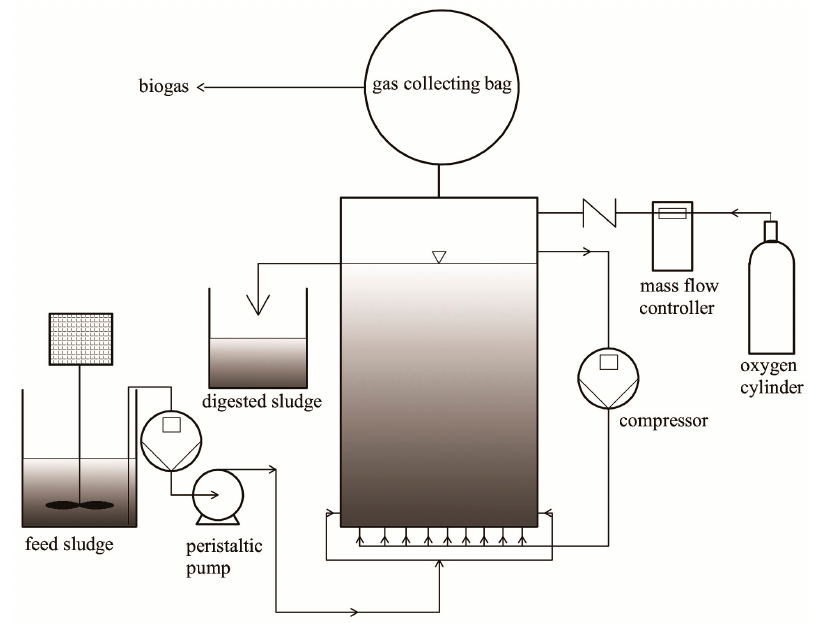
Figure 1. Lab-scale bioreactor diagram for the semicontinuous anaerobic and microaerobic digestion of activated sludge supplemented with rusty scrap iron (RSI).